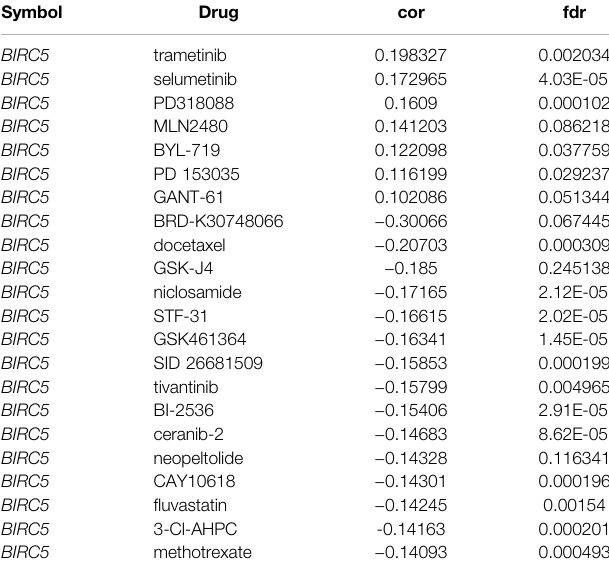
TABLE4| Analysisofthecorrelationbetween BIRC5 expressionanddiversedrug sensitivity by CTRP database.